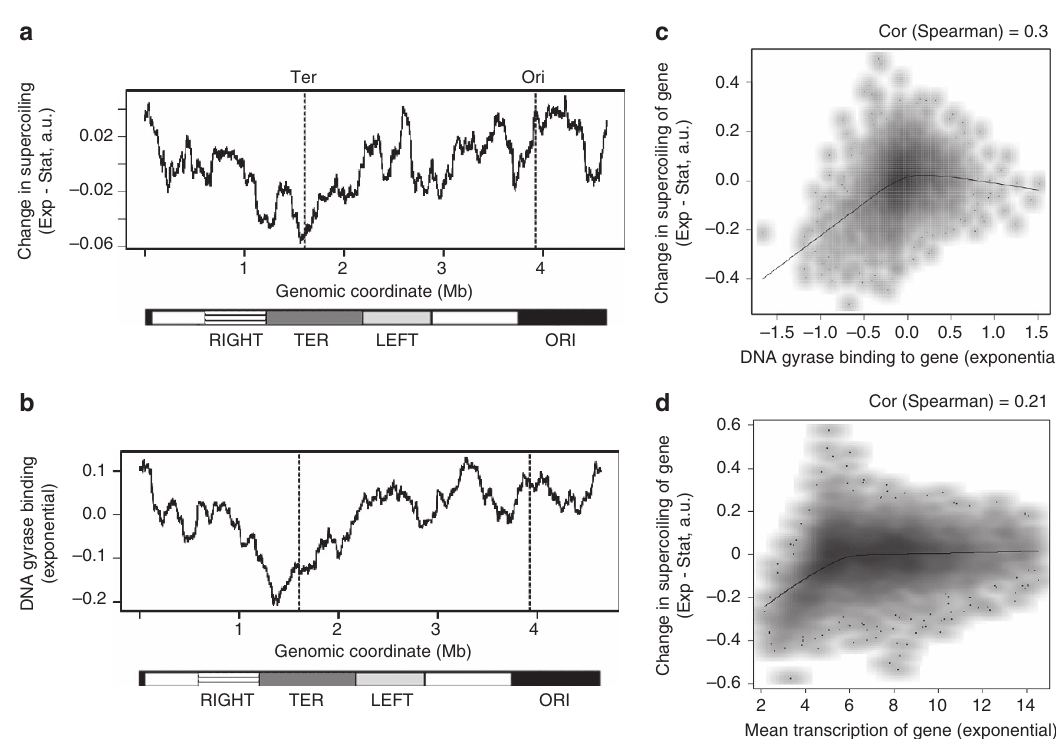
Figure 2 | The effect of DNA gyrase binding and transcription on chromosome supercoiling. ( a ) Change in negative supercoiling from stationary to exponential phase. The averages of the psoralen binding signals from both phases were scaled to zero before subtracting the stationary phase signal from the exponential phase signal. As overall negative supercoiling increases during exponential phase, this difference can be assumed to represent the relative increase in supercoiling across the chromosome. ( b ) Binding of DNA gyrase to the E. coli chromosome during exponential phase. Both graphs show the moving average of the signal with a window size of 200Kb. Dashed lines mark the positions of the terminus and origin of replication. Lower bars represent chromosomal macrodomains. ( c ) Smoothed scatter plot of the change in supercoiling from stationary to exponential phase versus DNA gyrase binding within genes in exponential phase. (Permutation test, P o 10 (cid:2) 5 ). Black line represents the loess fit. ( d ) Smoothed scatter plot of change in supercoiling from stationary to exponential phase versus exponential phase transcription level of genes. Black lines represent loess